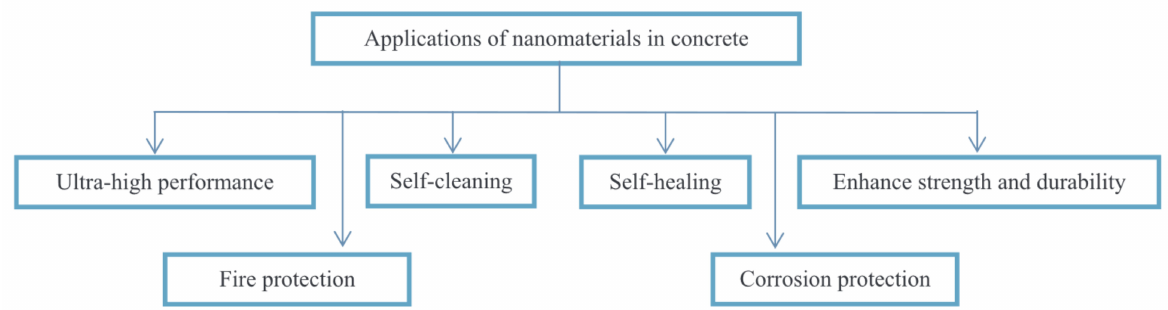
Figure 6. Applications of nanomaterials in concrete. Reproduced from